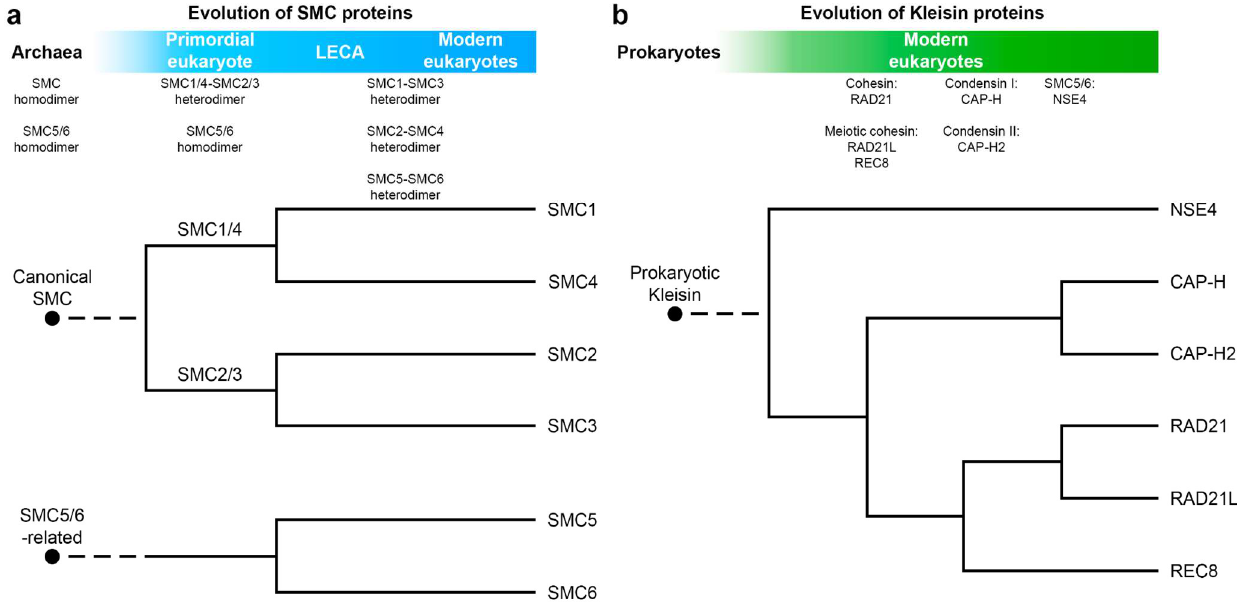
Figure 2. Origins of eukaryotic SMC and kleisin proteins. ( a ) A hypothetical model for evolution of SMC proteins in eukaryotes; ( b ) divergence of kleisins in modern eukaryotes.